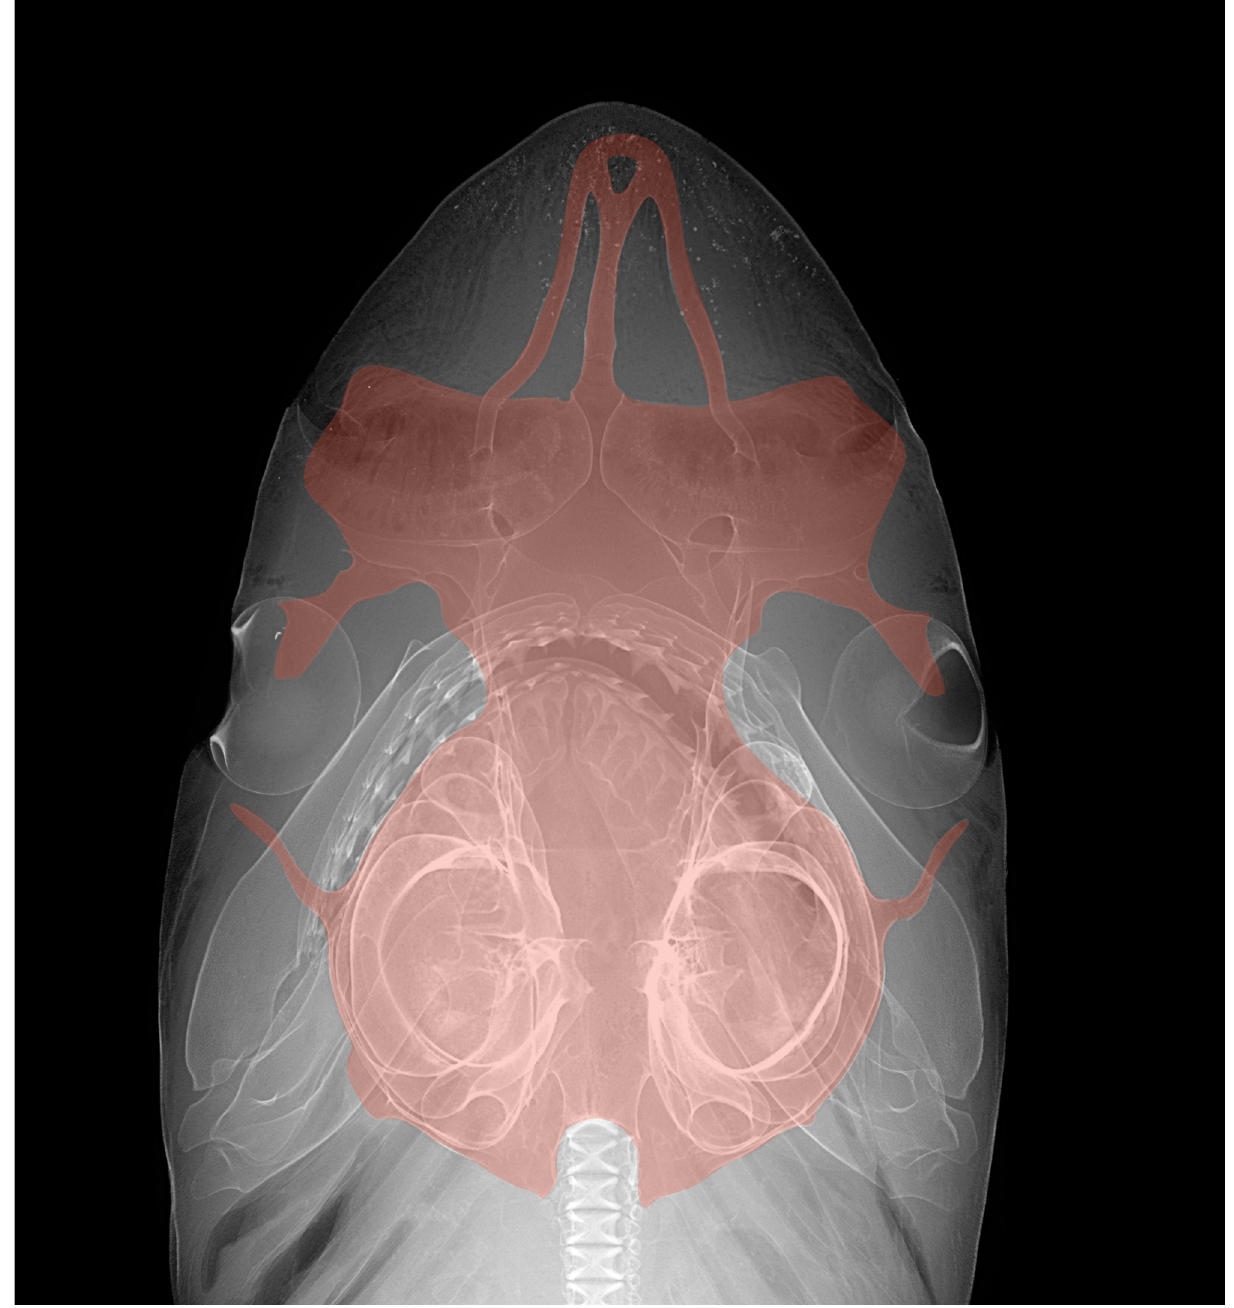
Fig 6. Digital radiograph of the head of Carcharhinus obsolerus sp. nov. (ANSP 77121, paratype). 370 mm TL female; chondrocranium highlighted in red.